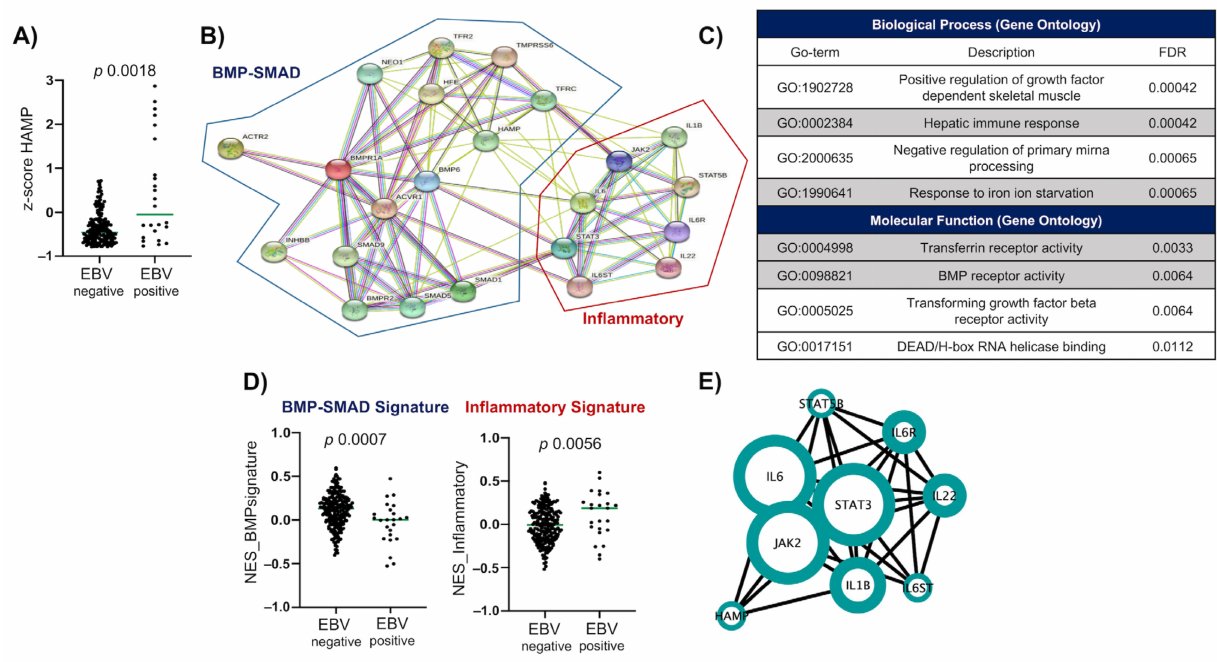
Figure 3. Elevated hepcidin ( HAMP) expression is enriched in the EBV-associated gastric cancer sam- ples (EBVaGC) through an inflammatory pathway. ( A ) HAMP expression in patients with EBVnGC (Epstein–Barr virus-negative gastric carcinoma) and EBVaGC. ( B ) Protein–protein interaction network (PPIN) of hepcidin and other proteins involved with hepcidin protein expression. ( C ) Gene Ontology (GO) analysis of biological processes and molecular functions related to the proteins of the PPIN. ( D ) Enrichment of BMP–SMAD and inflammatory signatures in EBVnGC and EBVaGC. ( E ) Centrality analysis where the size of the node represents the most important proteins in the PPIN, larger nodes indicate higher centrality. FDR = false discovery